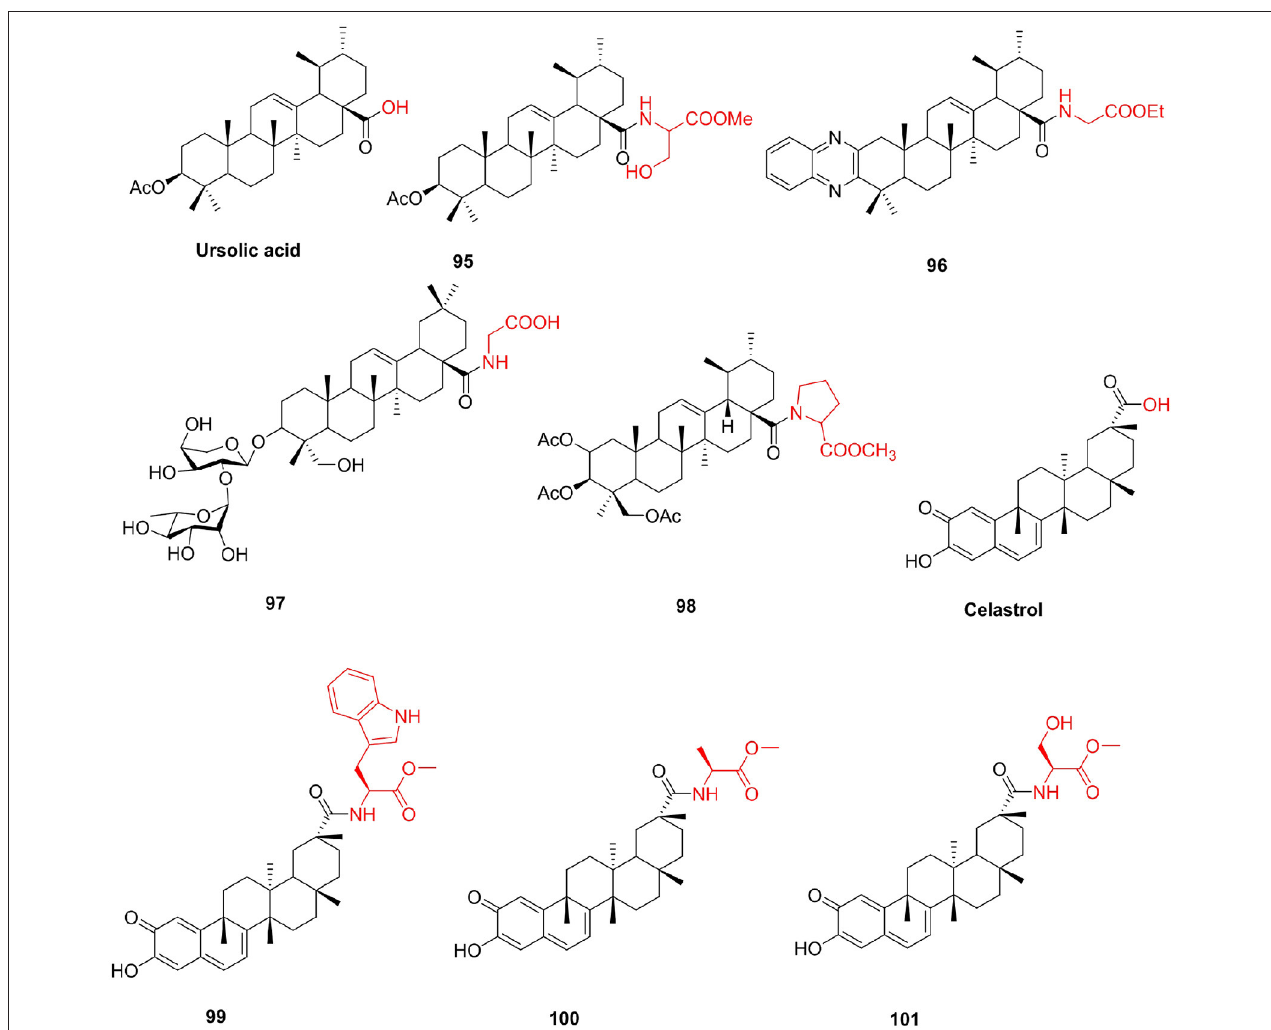
FIGURE 12 | Other triterpenoids